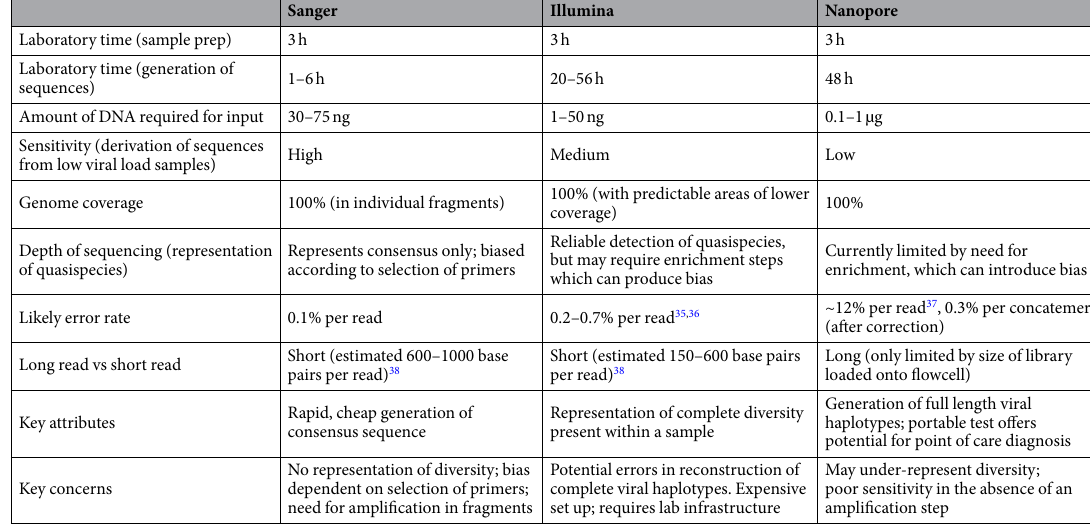
Table 2. Comparison of three methods of deriving HBV sequence